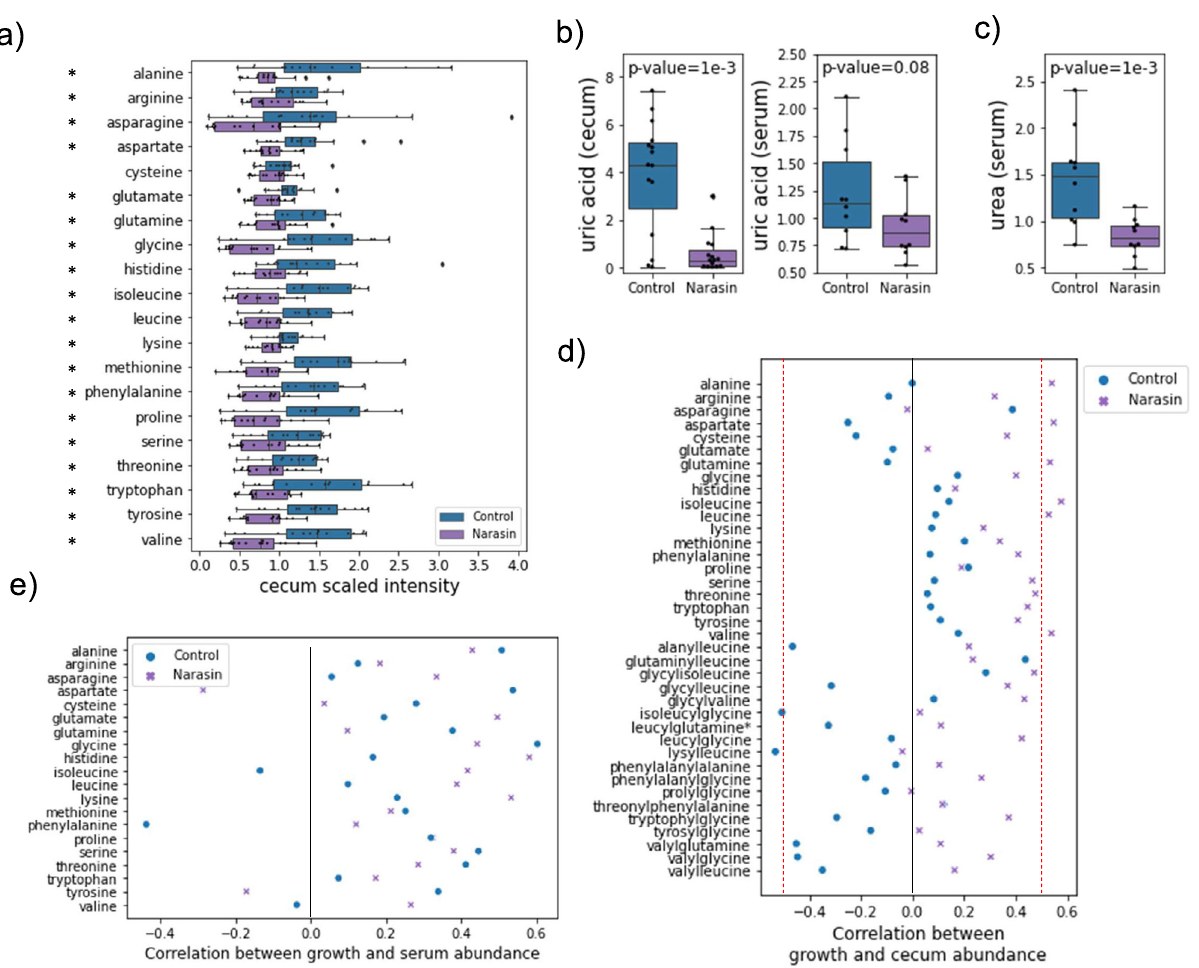
Fig. 6 Cecum and serum metabolites altered by narasin treatment. a ) The median-normalized ion counts (scaled intensity) of 20 amino acids in the cecum of control and narasin treated birds. *Welch ’ s t p-value < 0.05, n = 15 birds per treatment. b ) The scaled intensity of uric acid in the cecum and serum of control and narasin treated birds. c ) The scaled intensity of urea in the serum control and narasin treated birds. The boxes in a, b, and c represent the median and interquartile range; whiskers indicate the range of the distribution excluding outliers. d ) The correlation between the abundance of dipeptides and amino acids in the cecum and bird weight at day 35 for control and narasin treated birds. Dashed red lines represent the correlation threshold for p-values < 0.05. e ) The correlation between the abundance of amino acids in the serum and bird weight at day 35 for control and narasin treated birds. In panels d and e, the x-axis values show the Pearson correlation coef fi cient between the logarithm of the scaled intensities and physiology of individual microbes contributes to such processes (e.g. through genome-scale metabolic modeling), sets the stage for precision microbiome engineering for both animal and human health.